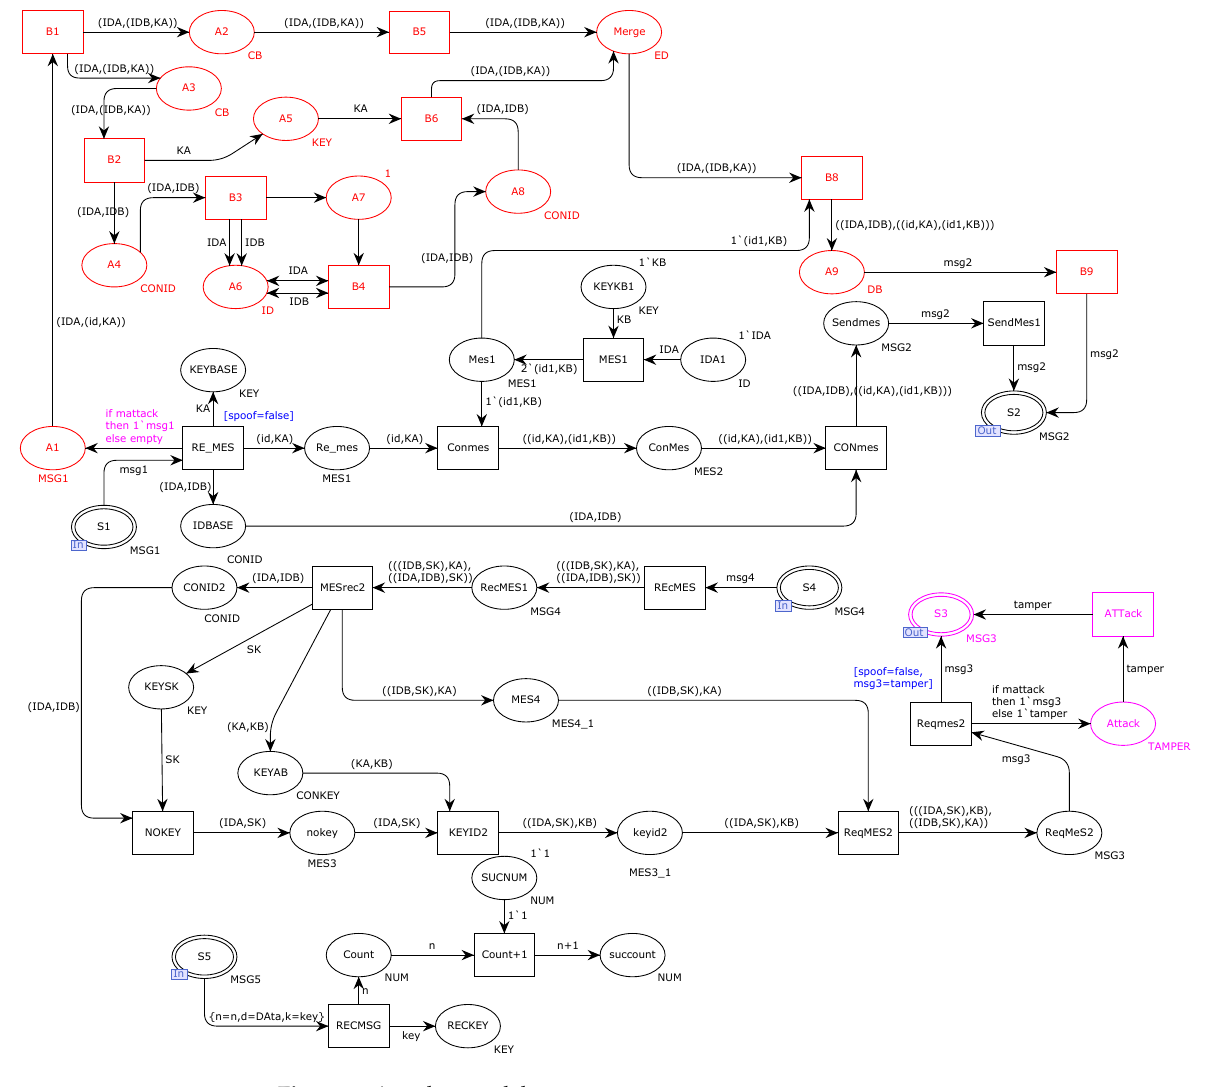
Figure 8. Attacker